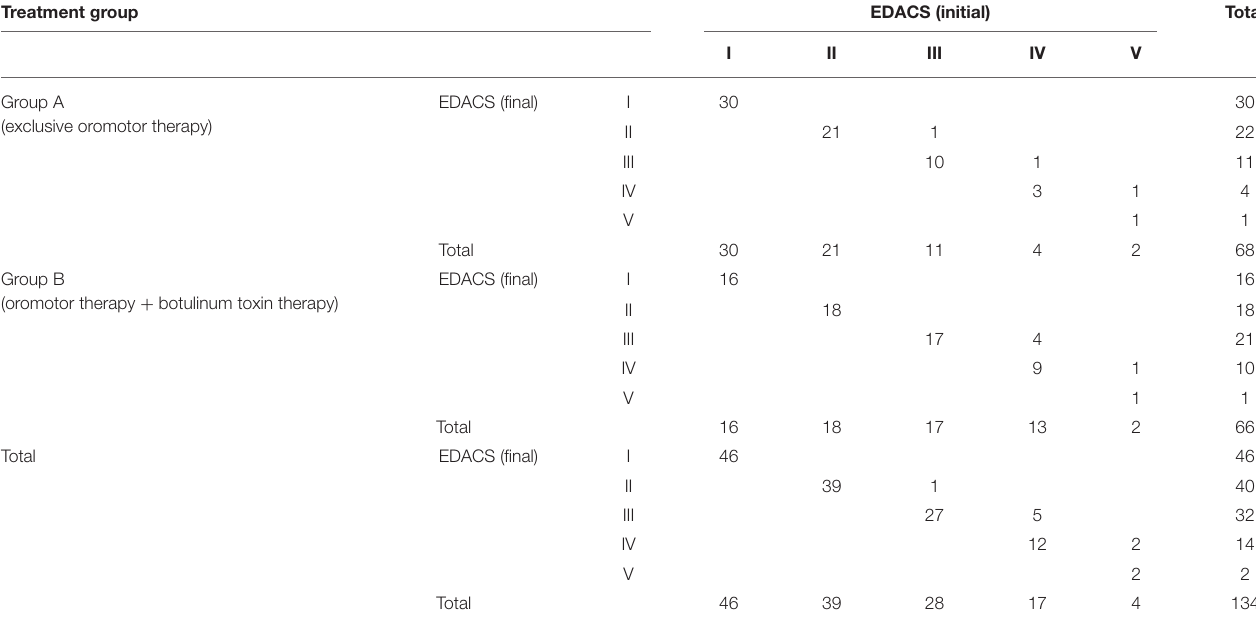
TABLE 2 | Swallowing efficacy and safety levels before and after evaluation by treatment group ( p < 0.001). Treatment group